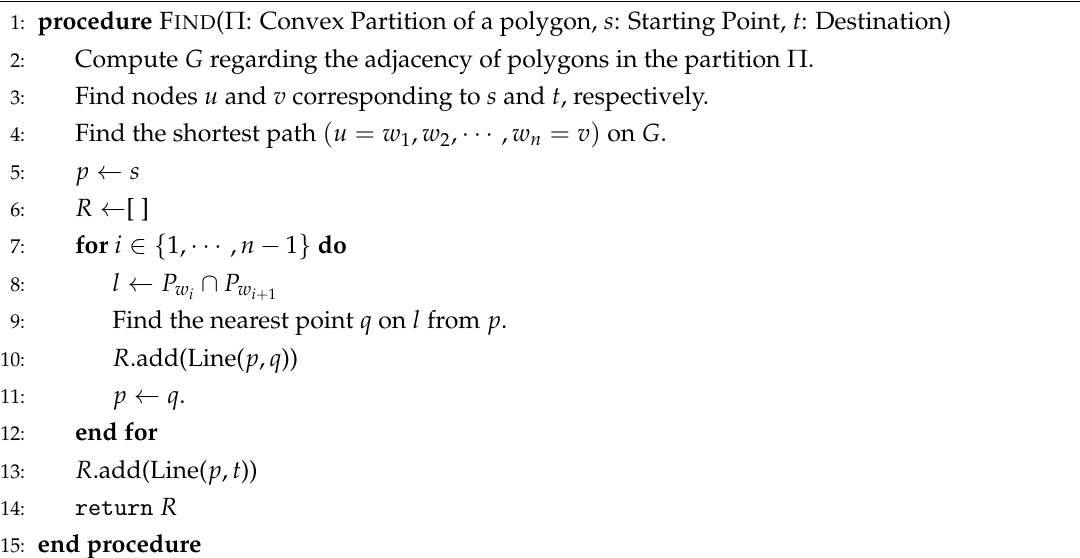
Algorithm 2 Finding a Path on Convex-Decomposed